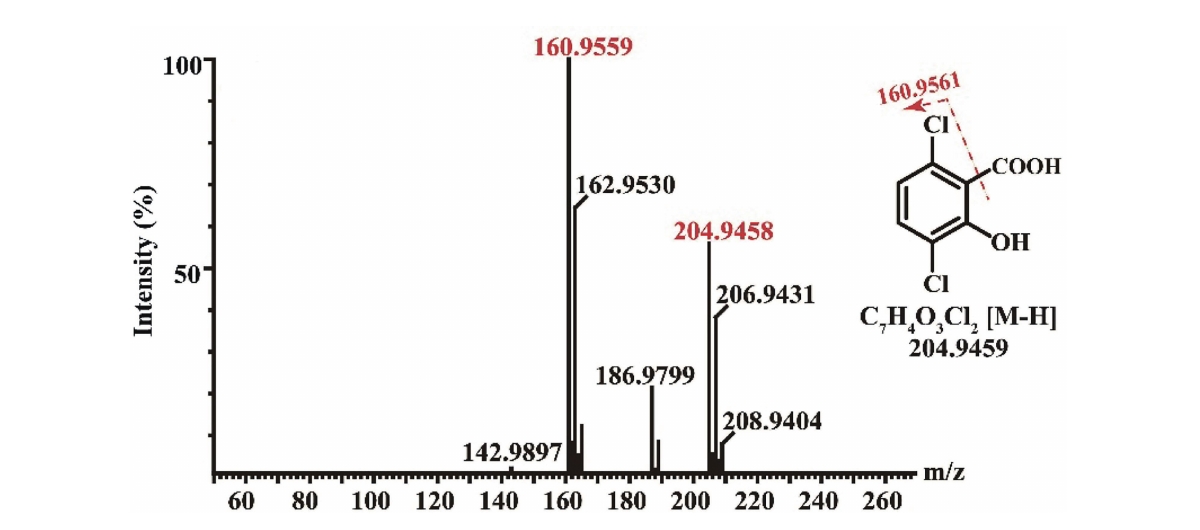
FIGURE 6 MS analysis of the product produced during dicamba conversion by